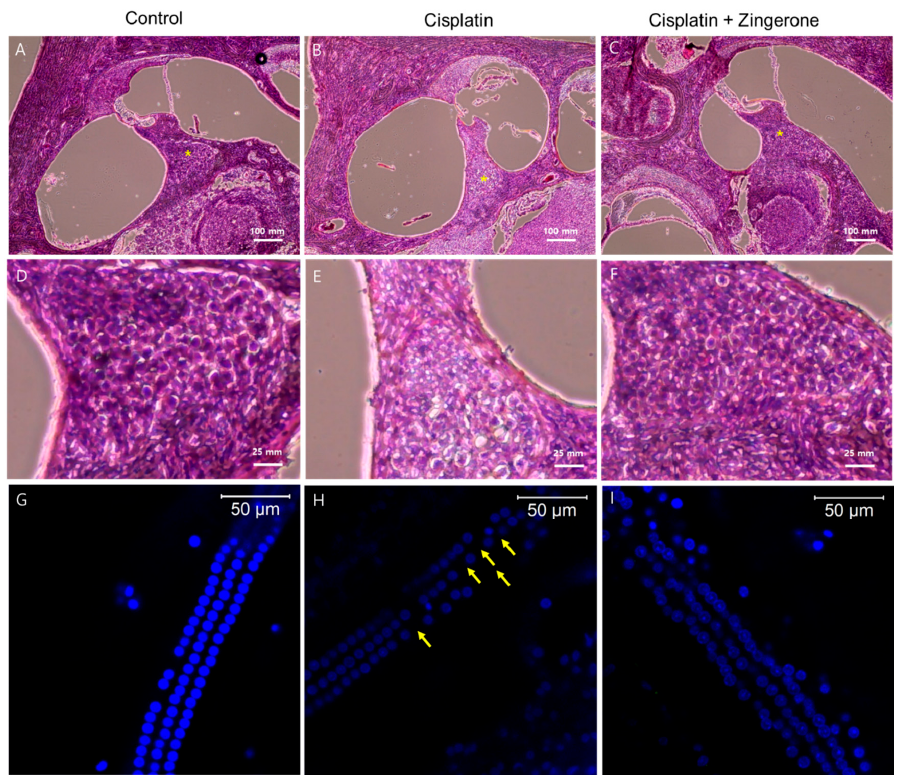
Figure 4. Hematoxylin and eosin (H&E) staining of the cochlea ( A – F ) and whole mounts of the cochlear basal turn ( G – I ). The control group exhibited intact spiral ganglion cells ( A ) and outer hair cells ( G ). Compared with the cisplatin group ( B , E , H ), the cisplatin + zingerone group ( C , F , I ) exhibited a preserved number and arrangement of spiral ganglion cells (* in A – C and D – F ) and outer hair cells (the arrows indicate the loss of outer hair cells).